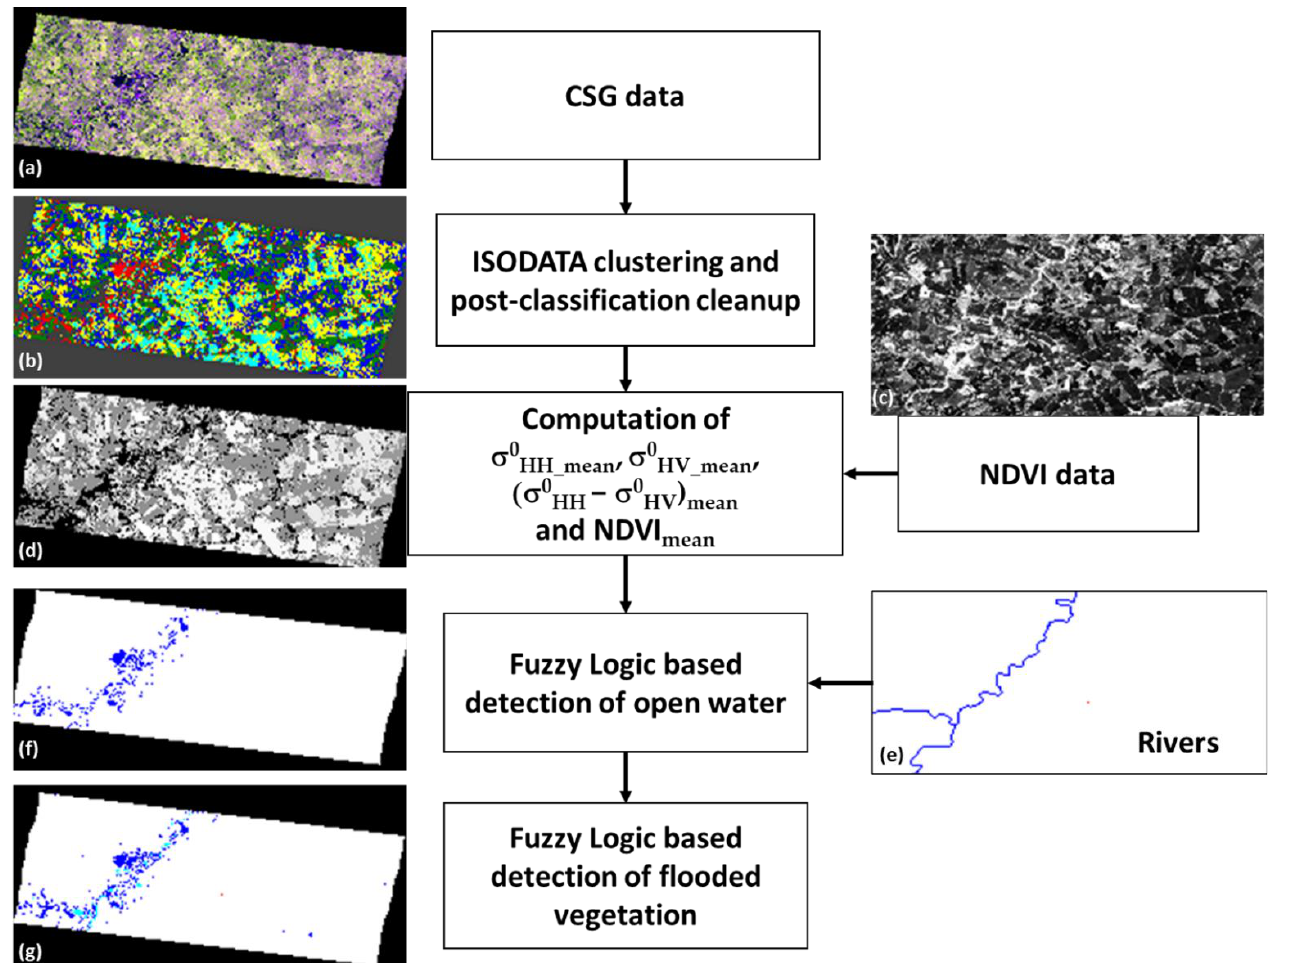
Figure 6. Workflow of the flood mapping methodology used in this study. The input data are the CSG images ( a ), the NDVI map ( c ), and the rivers’ network ( e ). The steps of the methodology are the ISODATA clustering (output shown in panel b ), the computation of the objects’ mean values (output shown in panel d ), the detection of open water (output shown in panel f ), and the detection of flooded vegetation (output shown in panel g ).